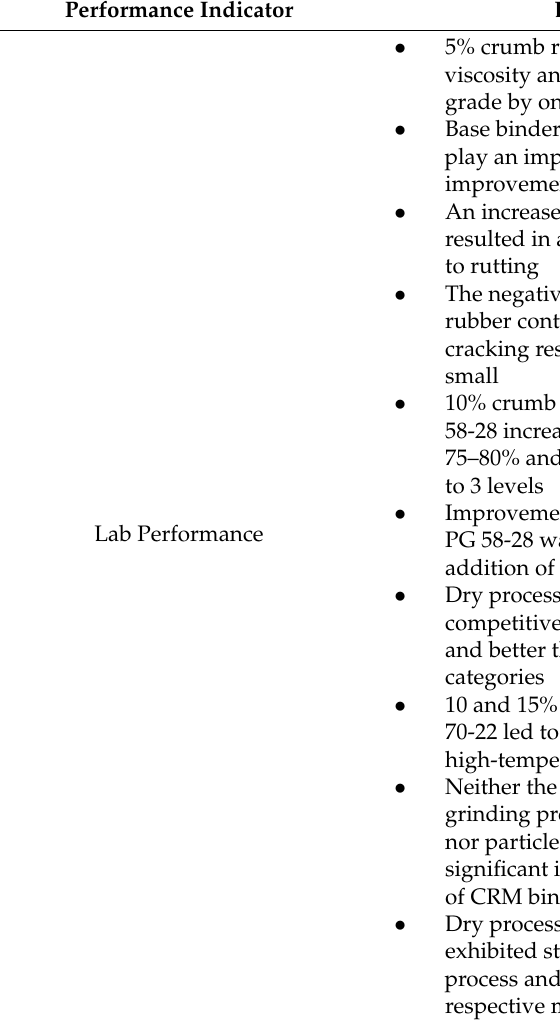
Table 4. Comparison of lab performance aspects of dry and wet processes. Performance